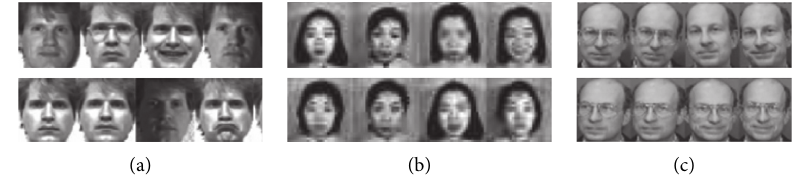
Figure 2: Samples in YALE, JAFFE, and ORL datasets. Table 1: The detailed information of the